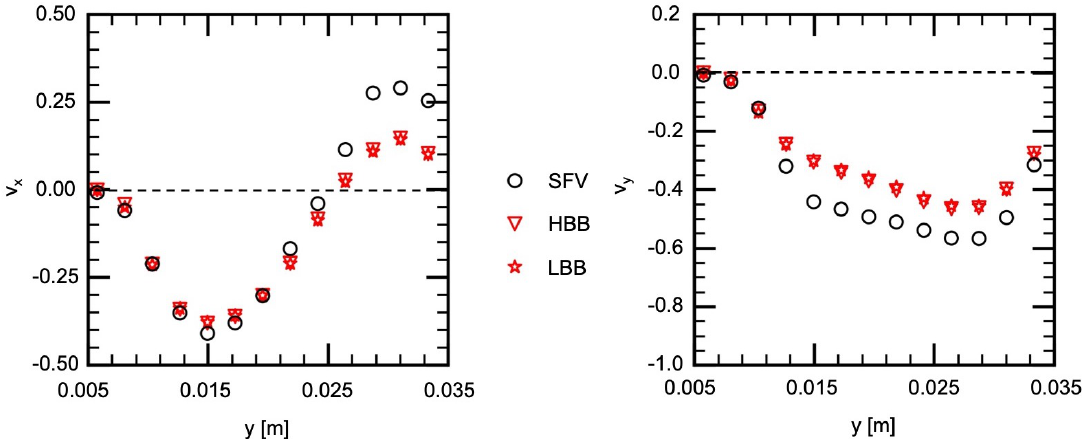
Figure 12. Comparison of velocity components between measured (SFV), HBB and LBB (line